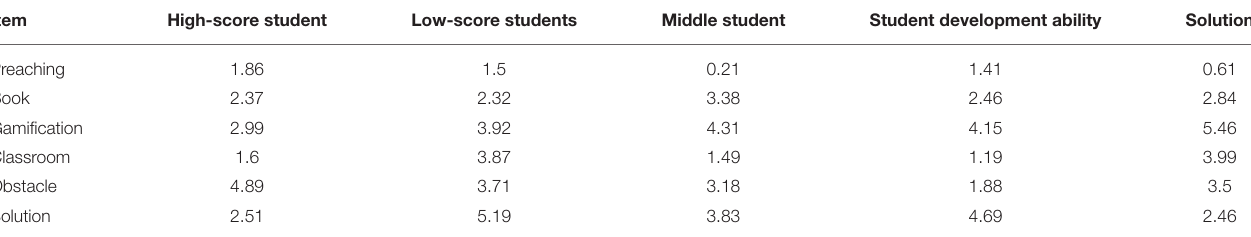
TABLE 3 | Small-scale teams are tacit knowledge